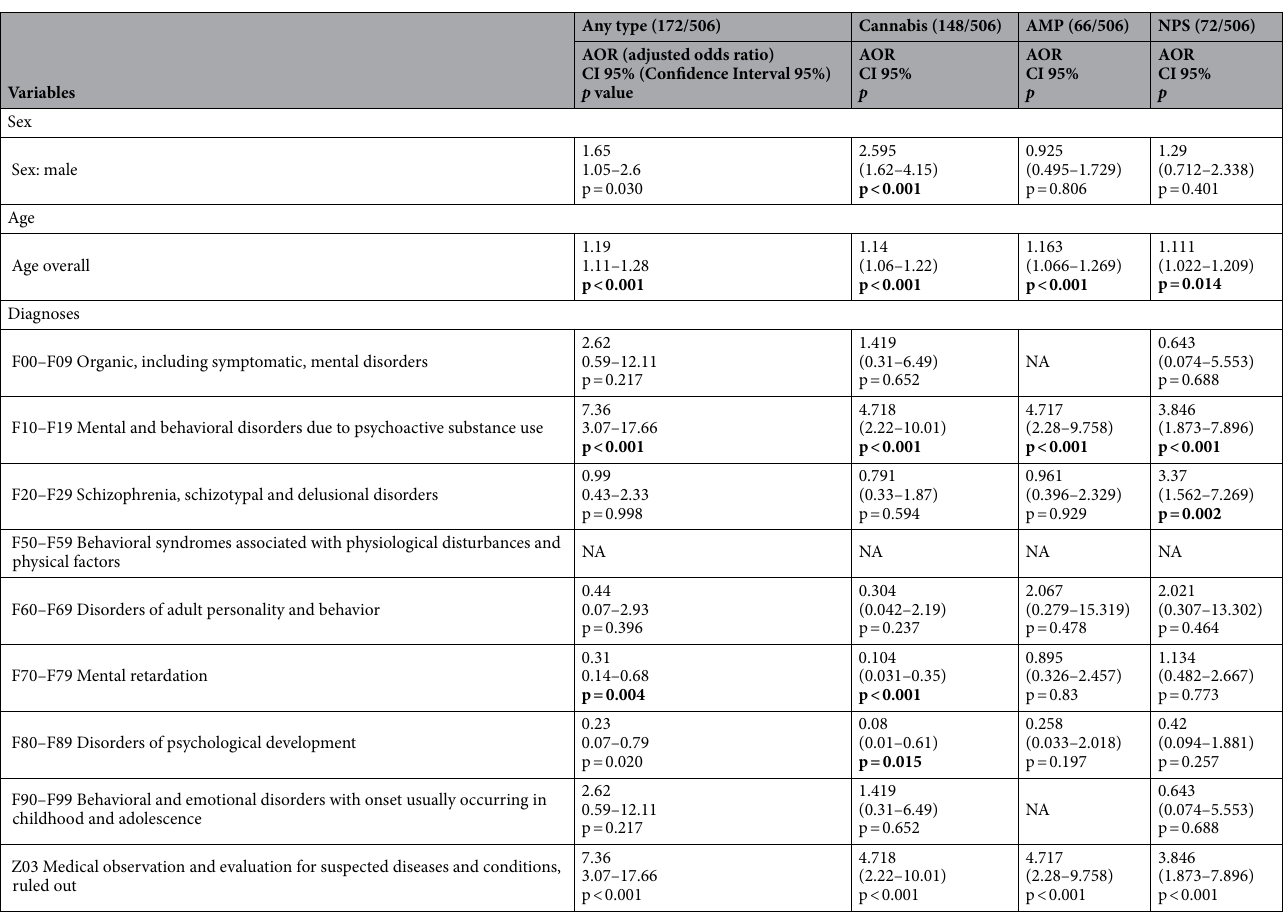
Table 7. Results of multivariable logistic regression (variables were entered simultaneously into the regression model). Only variables contributing significantly to the model were entered. Significant values are in